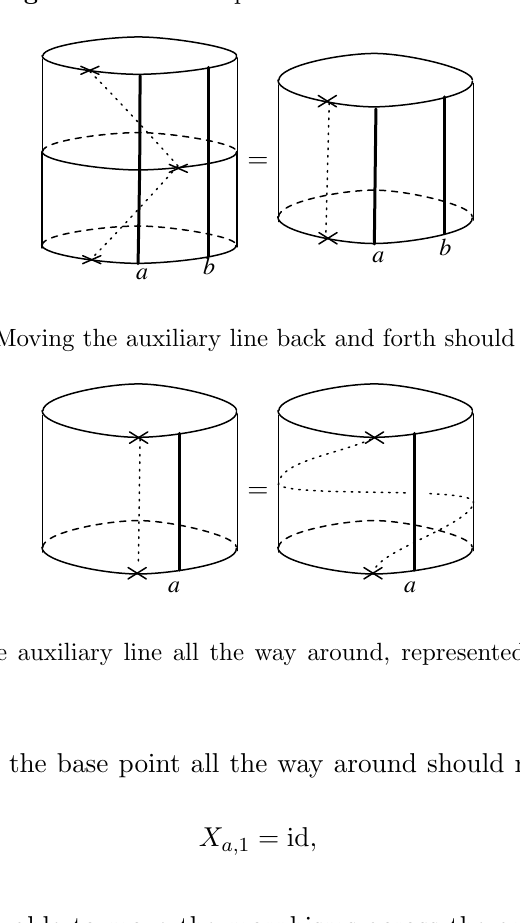
Figure 36 . Two morphisms can be combined.